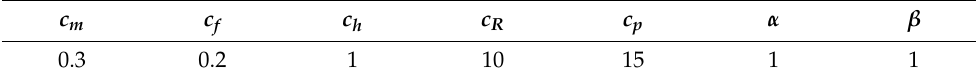
Table 1. Parameter